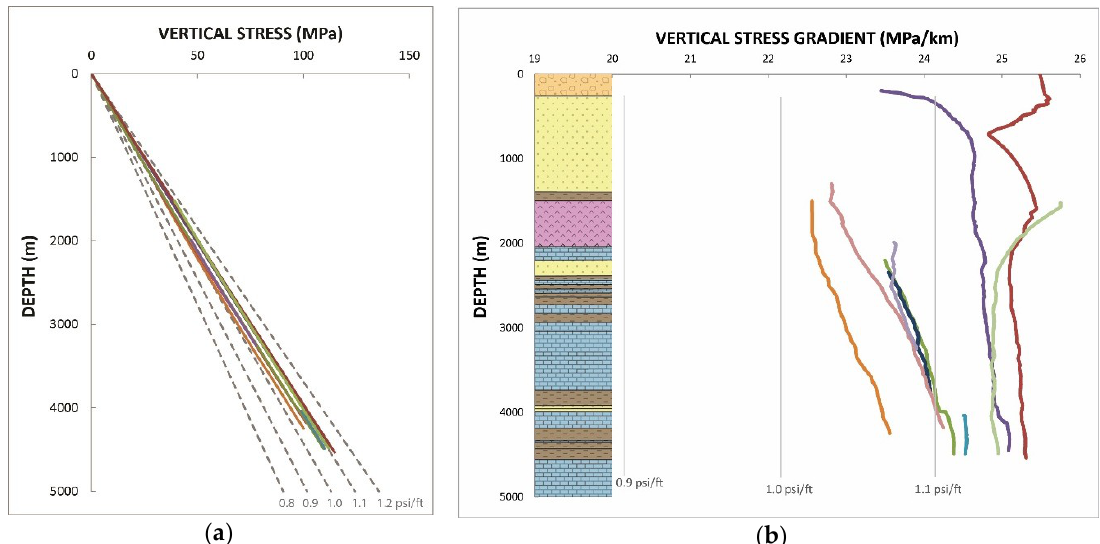
Figure 6. ( a ) Calculated vertical stress (σ v ) magnitudes over the Abadan Plain Basin. ( b ) Calculated σ v gradients of the Abadan Plain Basin. Vertical stress varies with depth and spatially between fields. Lithology column is from Reference [9].